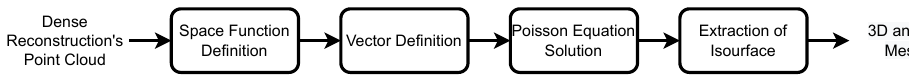
Figure 16. Diagram of the workflow to generate mesh